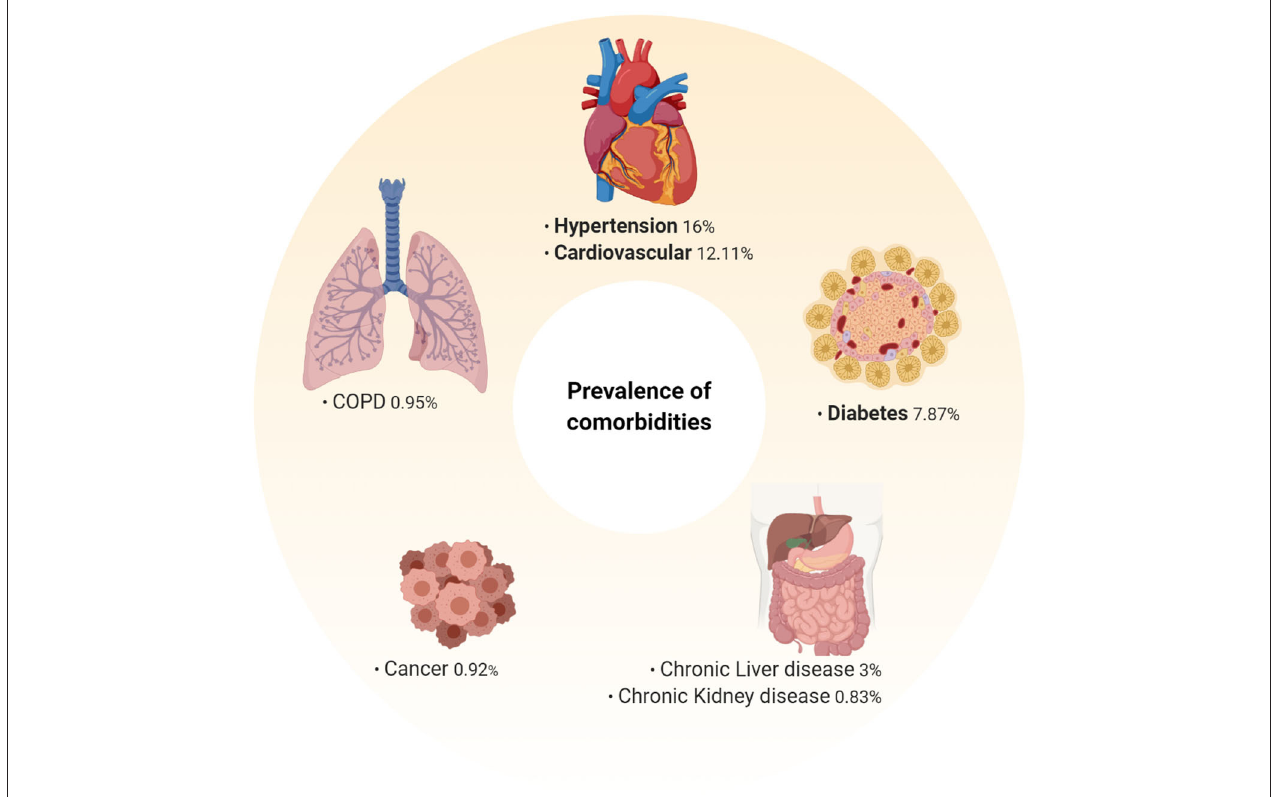
FIGURE 3 | Prevalence of pre-existing comorbidities among hospitalized COVID-19 patients. Prevalence of pre-existing comorbidities determined from an extensive meta-analysis of 76,993 hospitalized COVID-19 patients (1). Hypertension (16%), cardiovascular disease (12.11%), and diabetes (7.87%) were the most prevalent pre-existing co-morbidities. As this data is representative of hospitalized patients, the prevalence of these among mild/moderate cases may be different, and as more data is analyzed these may change.